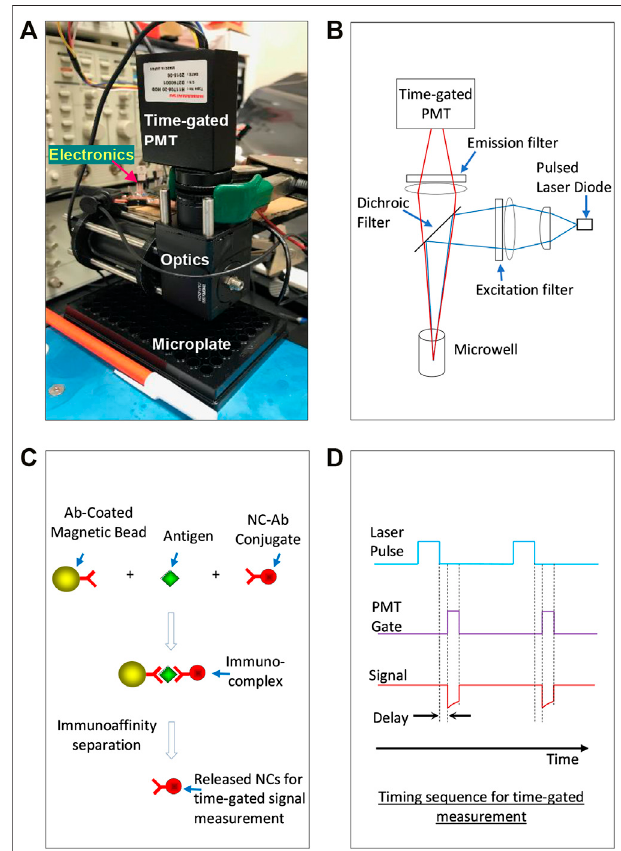
FIGURE 1 | (A) A small time-gated immunoassay platform integrating a time-gated optical detector and microplate-based immunoassay using Mn: AgZnInS/ZnS NC probes as signal transducers. (B) Principle illustration of the optical unit. (C) The immunoassay format performed in microwells of microplates: after antigens are switched between antibody-coated magnetic microbeads and antibody-conjugated NC probes, the NC probes are released from the immuno-switch-complexes into supernatants for time- gated signal measurement. (D) The timing sequence for time-gated measurement on the excitation laser and the